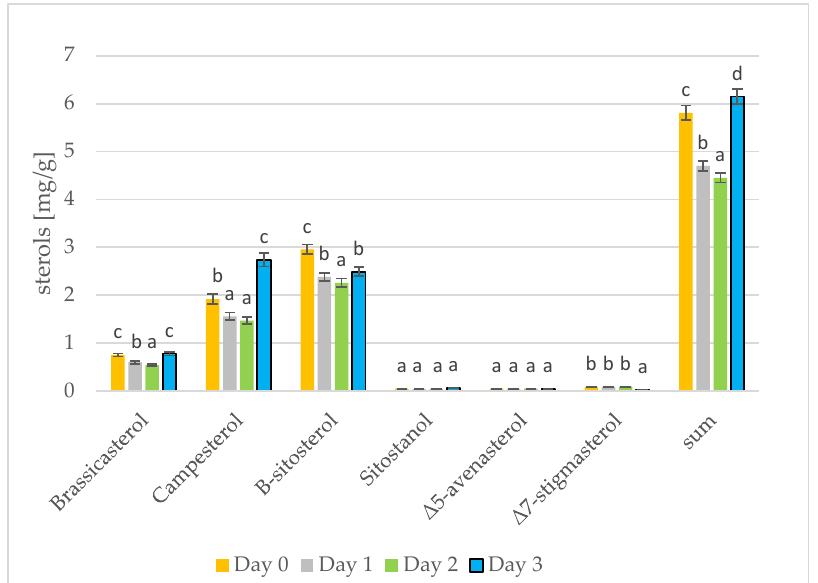
Figure 3. The level of individual phytosterols [mg/g oil] in rapeseed oils at different stages of germination (days 0, 1, 2, 3) (values are means ± SD from three experiments. Values with different letters are significantly different ( p < 0.05)).